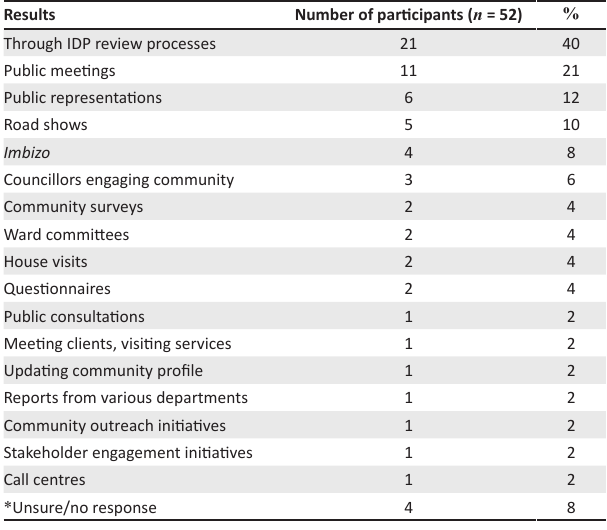
TABLE 1: Question 8a: Mechanisms for the identification of development